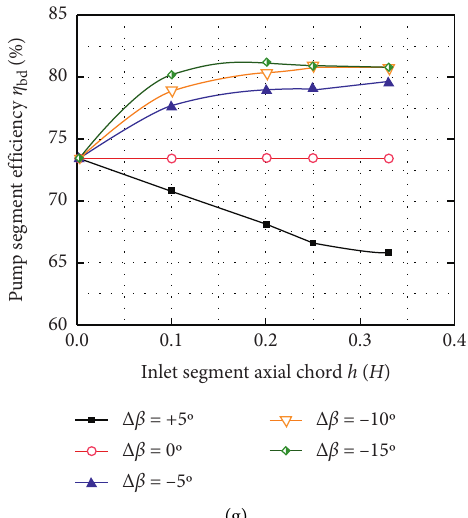
Figure 8: η h curves for each calculation scheme. (a) Q � 0.30 m 3 /s, (b) Q � 0.325 m 3 /s, (c) Q � 0.35 m 3 /s, (d) Q � 0.375 m 3 /s, bd ∼ (e) Q � 0.40 m 3 /s, (f) Q � 0.425 m 3 /s, and (g) Q � 0.45 m 3